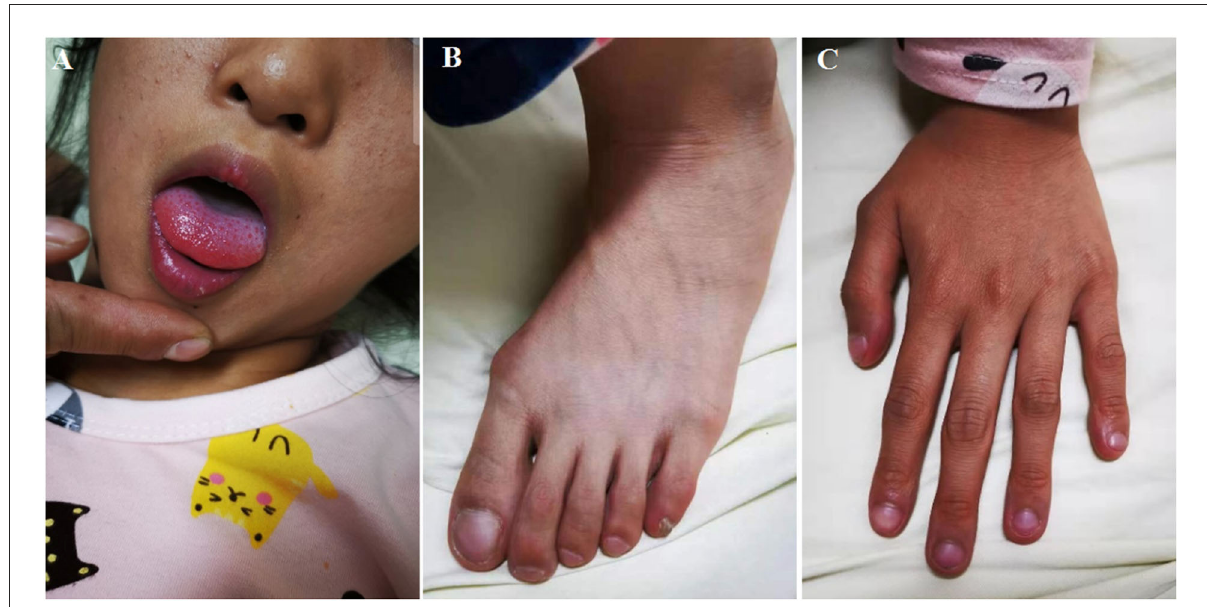
FIGURE1 The girl has mild cyanosed lips (A) , digital clubbing in toes (B) and fingers (C) of high-density shadows in both lungs. Electrocardiogram (ECG) and echocardiogram were both